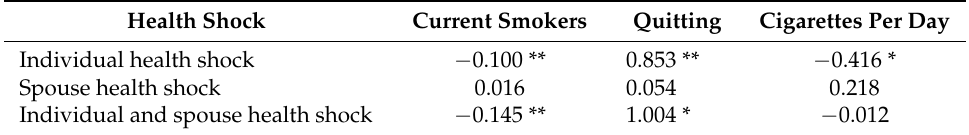
Table 3. Marginal effects of health shocks on smoking behaviors with individual random effects logistic